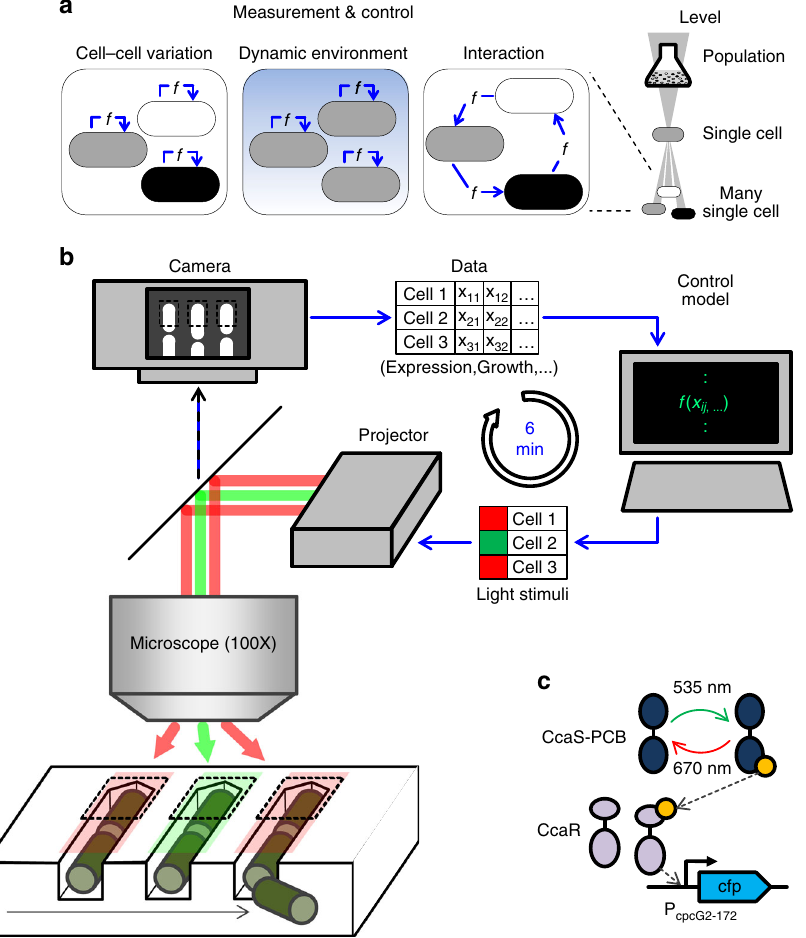
Fig. 1 An experimental platform for independently programmable optogenetic control of gene expression in individual bacteria. a Online measurement and control (cell out-, in-arrows) coupled through an experimental platform ( f ) of many single bacteria enables probing single-cell heterogeneity, effects of environmental variability in individual cells, and group behaviors of interacting individuals. b Experimental platform overview: individual bacteria are cultured for days in de fi ned chemical environments within a micro fl uidic “ mother machine ” device. Fluorescent reporter expression, cell shape, and growth rate of the mother cell at each control location (dashed box) is automatically extracted from microscope images and provided to the cell ’ s individually speci fi ed software controller. The controllers output stimuli to up- or downregulate a light-responsive gene for each cell. The individual stimuli are collected, spatially arranged and transmitted to the recipient cells using a custom-modi fi ed microscope-coupled LCD projector. This process is repeated every 6 min. c Cerulean CFP expressed via an optimized CcaSR optogenetic regulation system 31 . CcaS-phycocyanobilin autophosphorylates under green light (535 nm), then phosphorylates CcaR, which binds and activates expression from the PcpcG2-172 promoter. Exposure to red light (670 nm) dephosphorylates CcaS, eventually halting